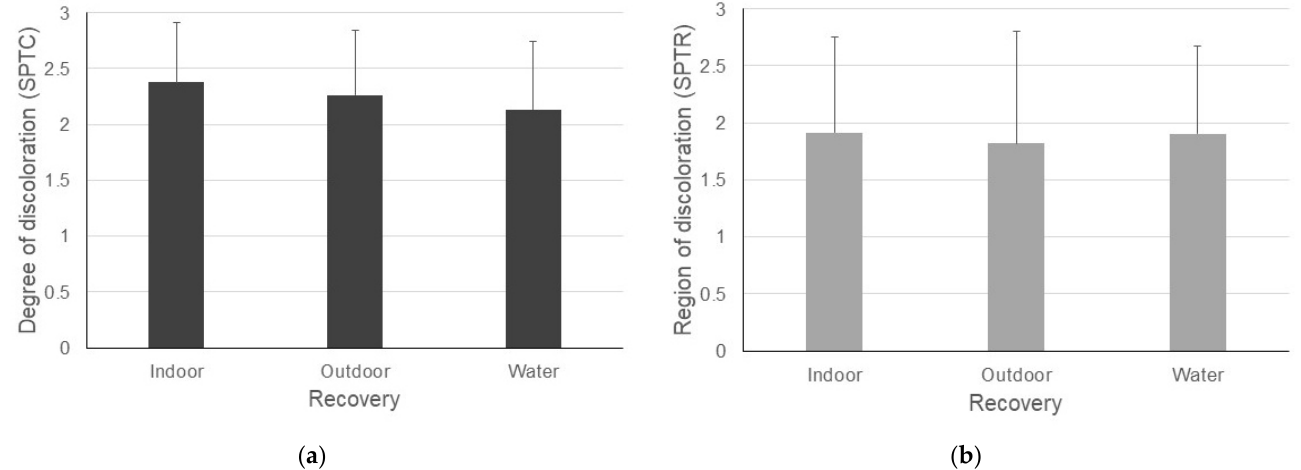
Figure 6. Association of SPTC ( a ) and SPTR ( b ) with place of recovery (68 cases, n = 11–36). There were no significant differences for either score. SPTC, Score of Pink Teeth Color; SPTR, Score of Pink Teeth Region.